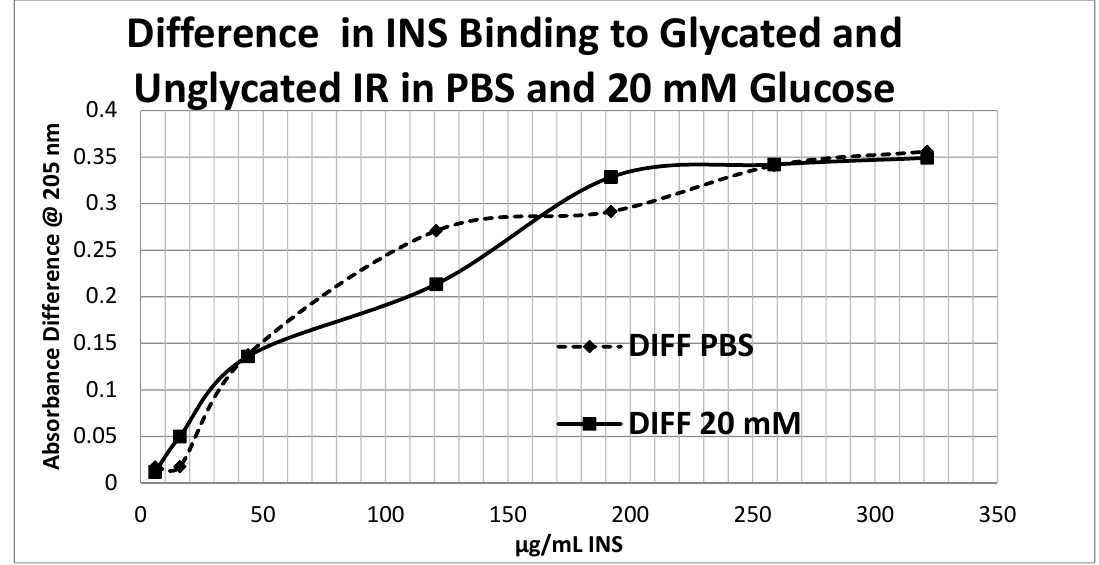
Figure 14. The difference in insulin (INS) binding to glycated and unglycated insulin receptor (IR) in PBS with and without 20 mM glucose. Note that although the binding constants of INS binding under these conditions differed (see Figures 12 and 13), the effect of glycation on decreasing INS binding was the same. Thus, the diminution in INS binding to glycated IR is independent of the presence or absence of free glucose.